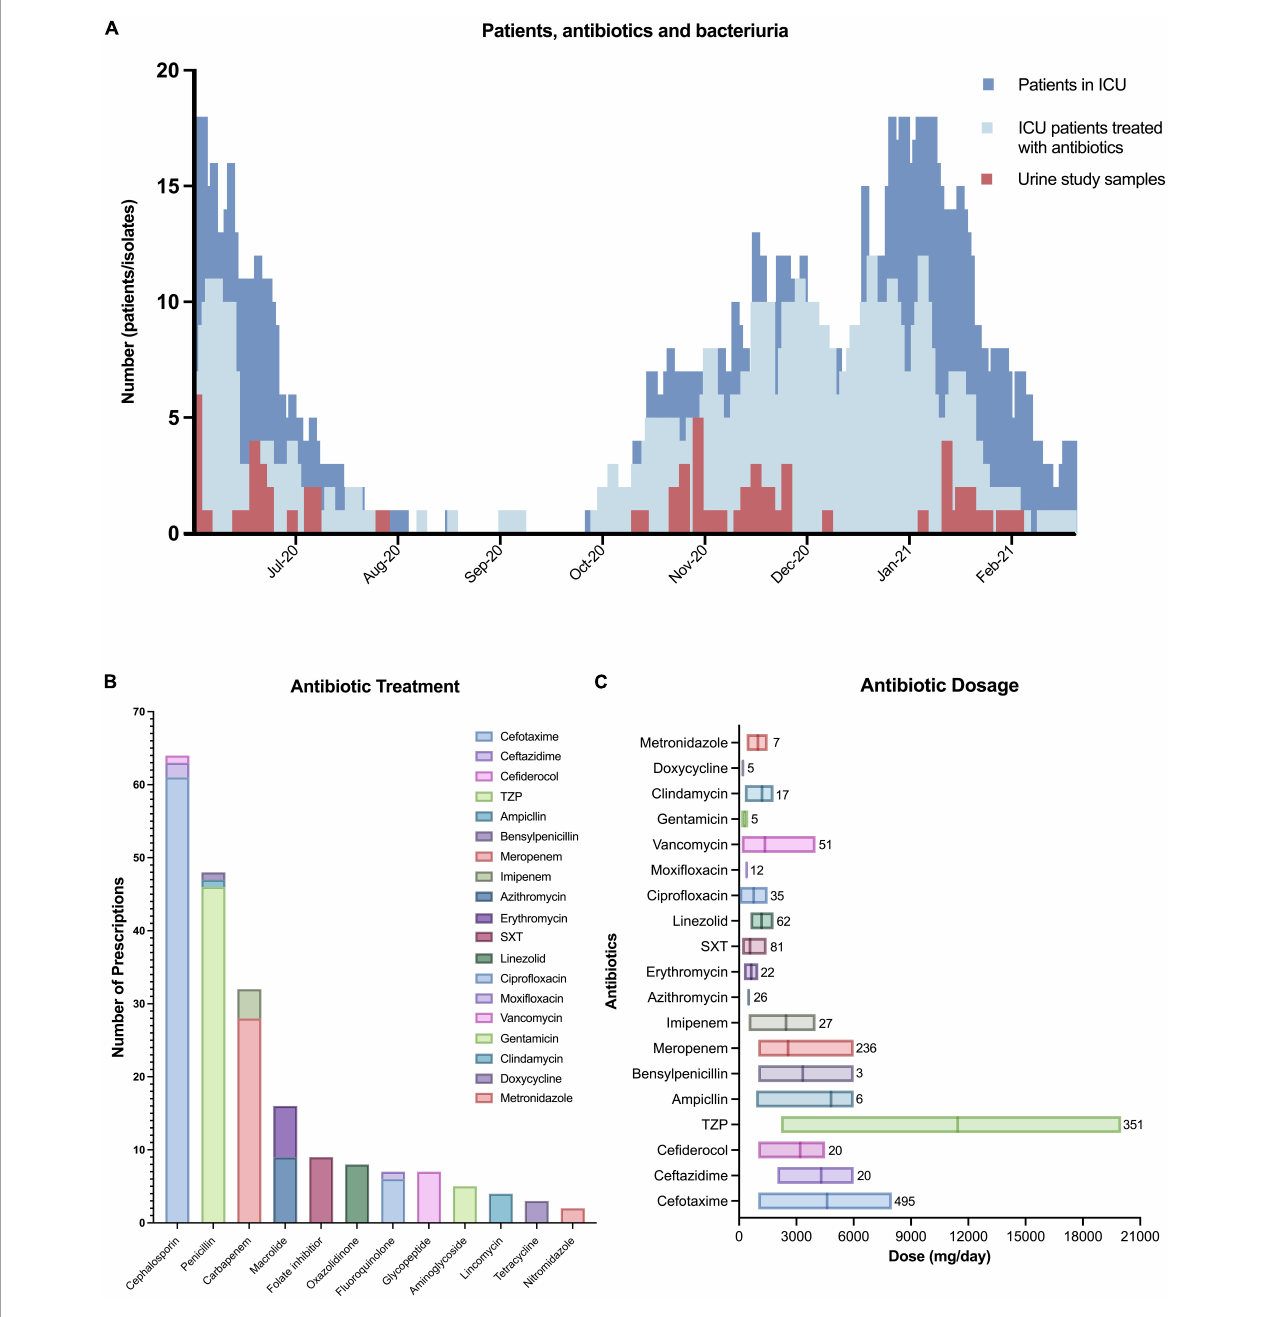
FIGURE3 Antibiotic treatment. (A) Epidemiological overview of all patients admitted to the Uppsala university hospital intensive care unit (dark blue) according to the Swedish Intensive Care Registry (SIR), the number of ICU patients in our cohort receiving at least one antibiotic (bright blue), and the number of urine study samples identified (red). (B) The number of prescribed antibiotics where each antibiotic is counted maximum once per patient. TZP, piperacillin-tazobactam; SXT, trimethoprim-sulfamethoxazole. (C) The dose of antibiotic prescriptions with the internal line marking the mean and the box number indicates the total number of prescription